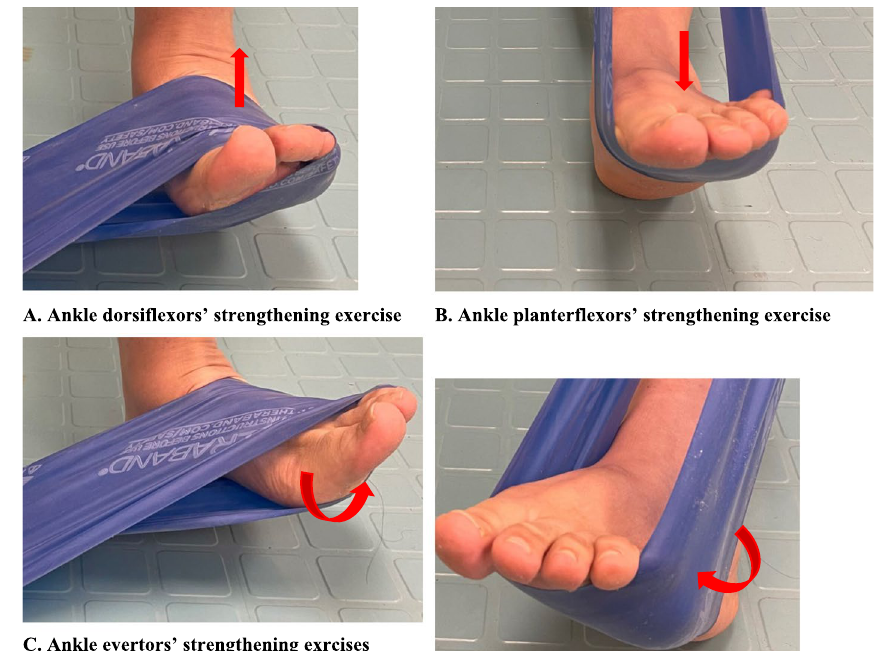
Fig. 2 Ankle strengthening exercises using